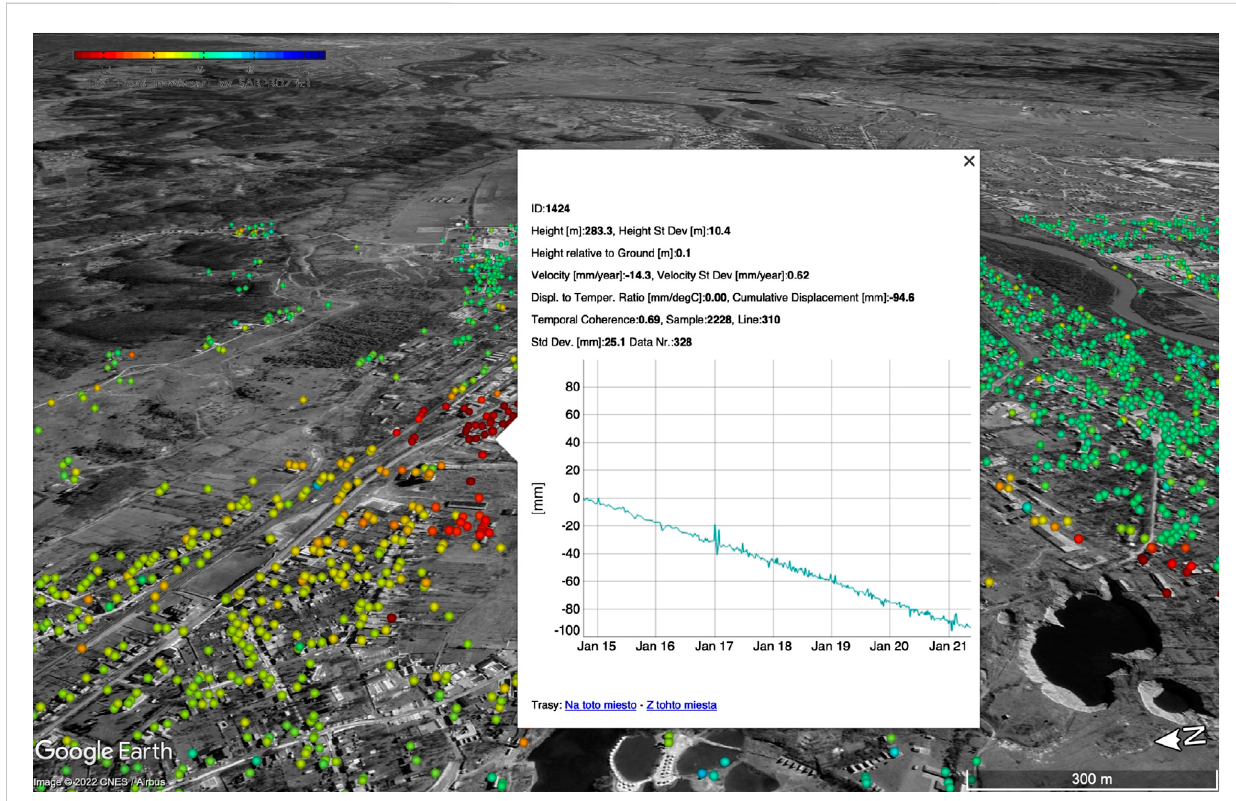
FIGURE 6 Displacement time-series from Descending Track No. 7 shown for the subsiding area from the point over the industrial building with the velocity of − 14.3